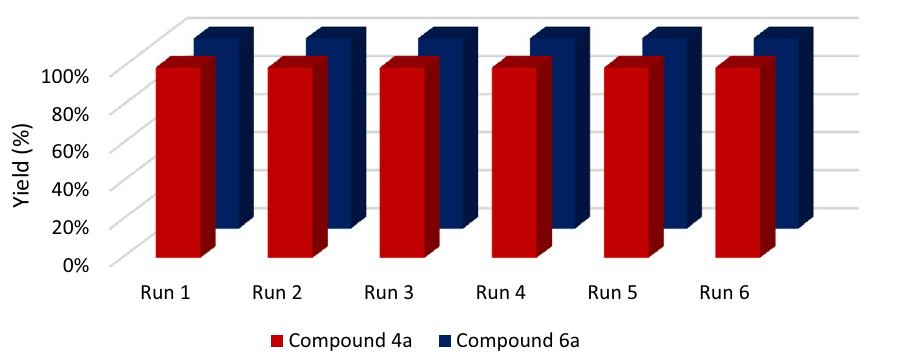
Figure 10. Reusability of the catalysts in the synthesis of compounds 4a and 6a.